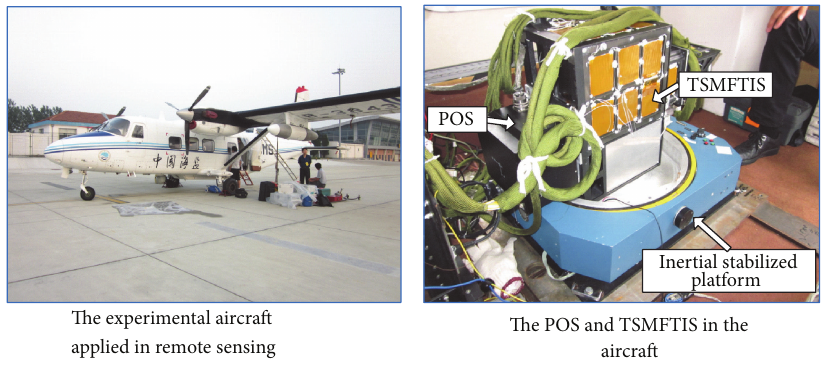
Figure 9: The airborne application experiments.